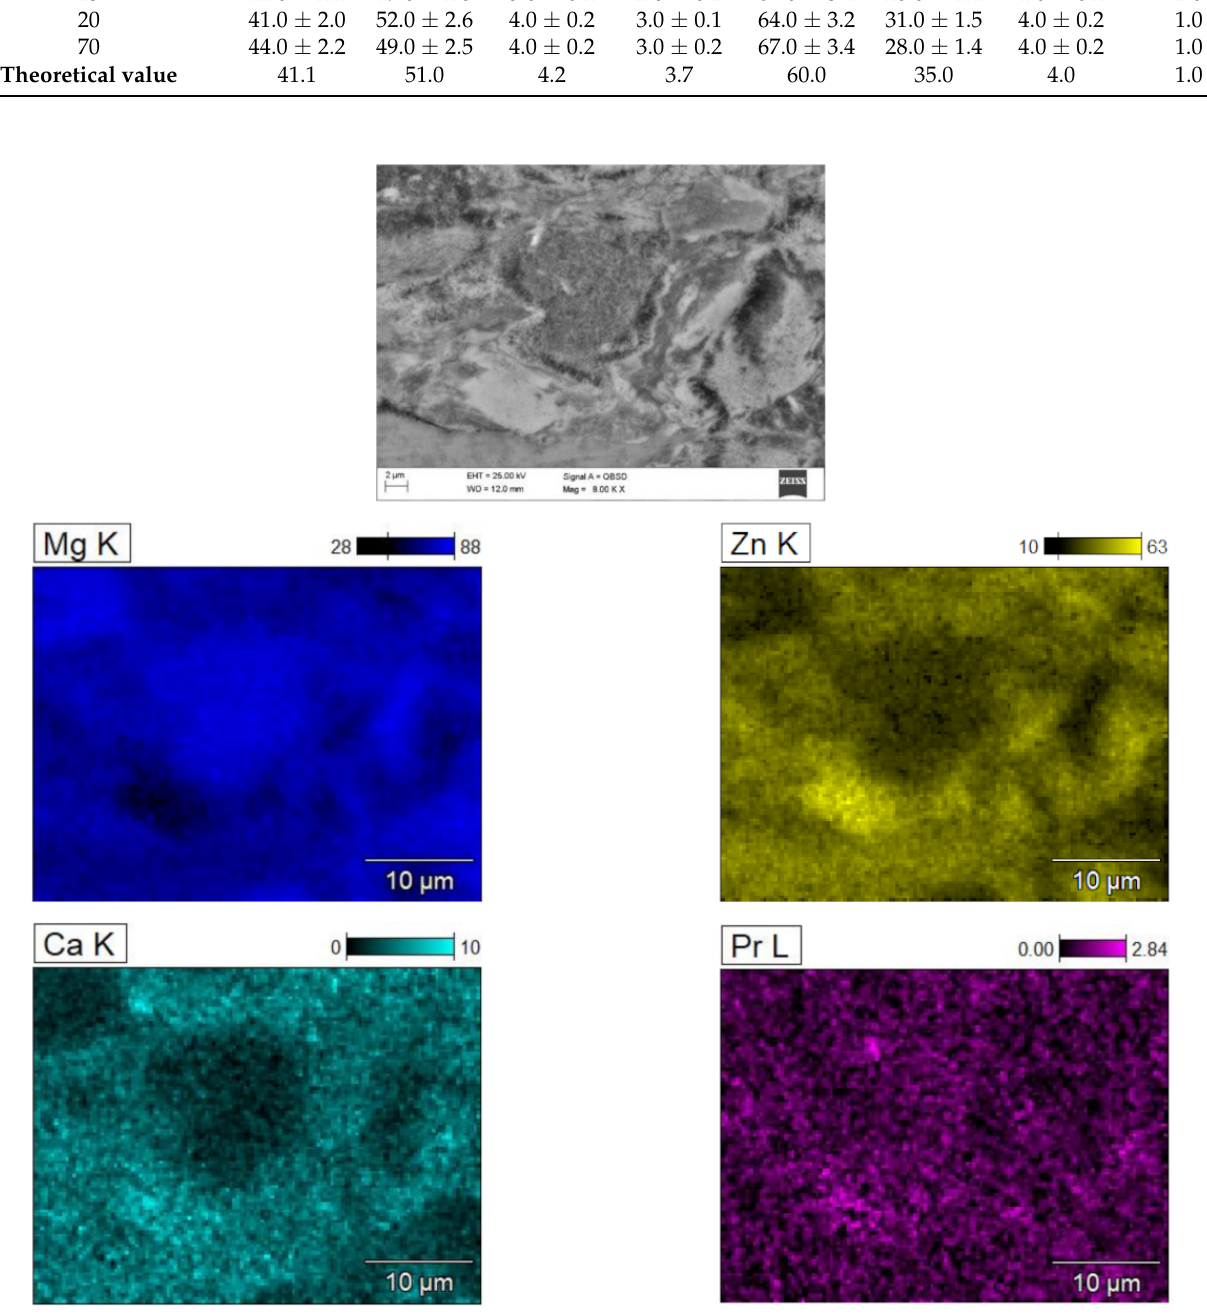
Figure 10. Element maps show the spatial distribution of elements performed on the energy disper- sive spectrometer for the selected sample after 20 h of milling time. The areas of the components of the alloy are presented in different colors, i.e., blue, yellow, green, and purple for magnesium, zinc, calcium, and praseodymium,